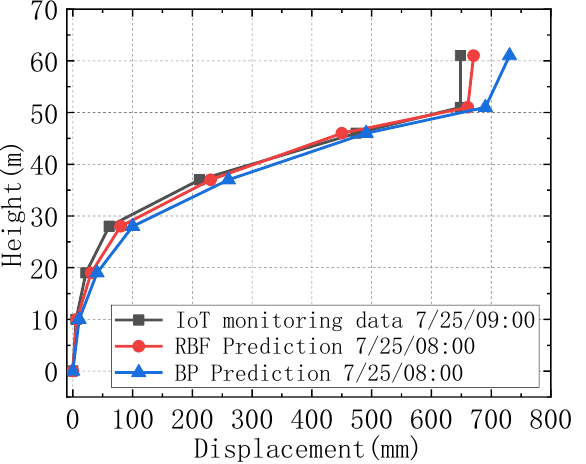
Figure 15. Comparison of the predicted daily maximum displacement of the tower with the actual measured data.